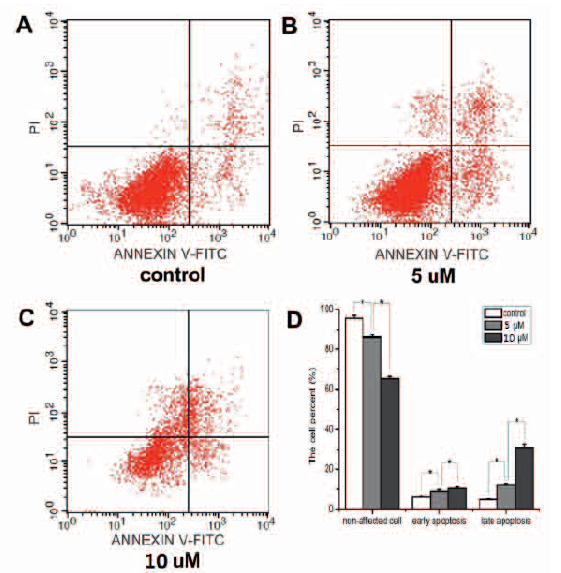
Figure 2. Effect of Scutellarein on the apoptosis of SAS cells. Apoptosis of SAS cells shown by annexin-V/PI staining after treated with 5 and 10 µM scutellarein for 96 h, with data showing the percentages of non-affected, early and late apoptotic cells. All values are given as mean ± SEM from three independent experiments. *P < 0.05 compared with each other. Figure 3. Effects of scutellarein on the ultrastructural changes of SAS cells. Cells were treated with various concentra- tions of scutellarein (5, 10 µM) and incubated for 96 h. The morphologic change of SAS Cells was detected by transmission electron microscopy. a, Control cells have large nucleus, rich chromatin and microvilli, and integral organelles. b, c: Nucleus shrunk ( ), chromatin condensa- tion ( ), mitochondria swelled ( ) and even mitochon- drial crest dissolved to form myeloid changes ( ) after treatment with 5 µM scutellarein. d, e: Microvilli defl uxion, chromatin margination plaque, mitochondrial vacuolar degeneration ( ) and even apoptotic body ( ) formed after treatment with 10 µM scutellarein. a, b and e: Bar=5 µm; c and d: Bar=1 µm